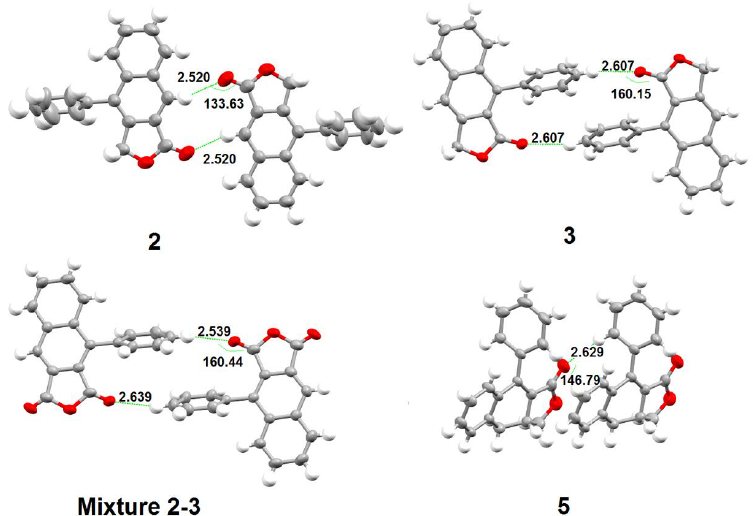
Figure 3. Intermolecular close-contacts in 2 , 3 , mixture 2-3 and 5 .